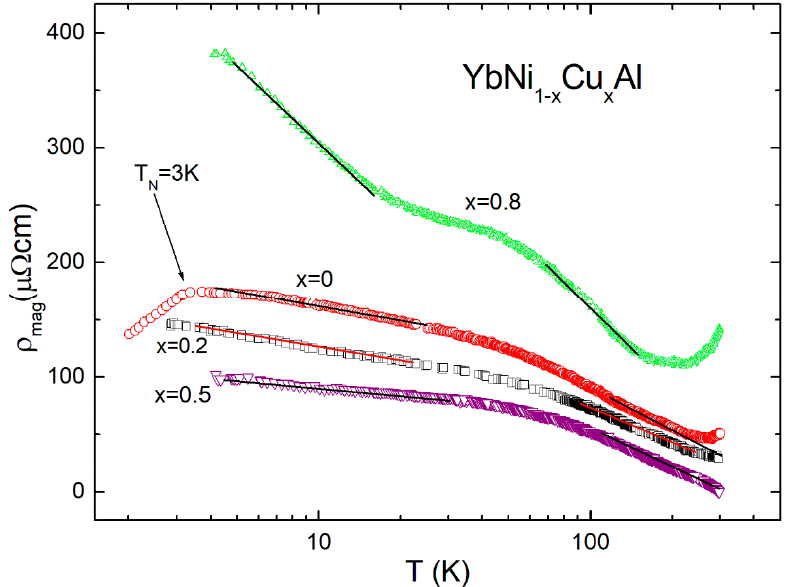
Figure 5. Magnetic contribution vs. temperature (in logarithmic scale) obtained by subtraction of the experimental data in YbNi 1 − x Cu x Al alloys using reference YNi 1 − x Cu x Al series. Two regions with − lnT dependence are observed.